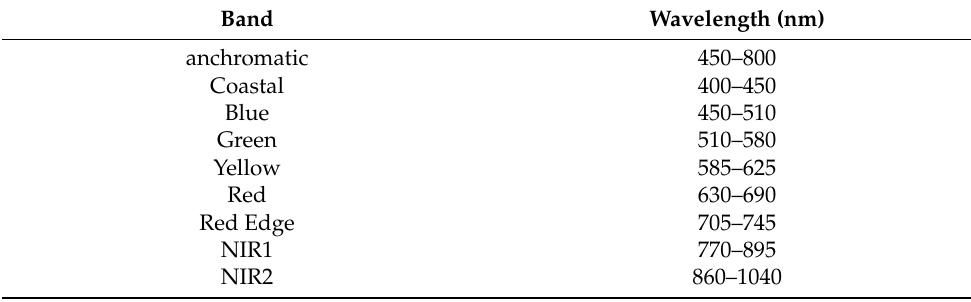
Table 1. The bands of WorldView-3 used in this study. NIR: Near